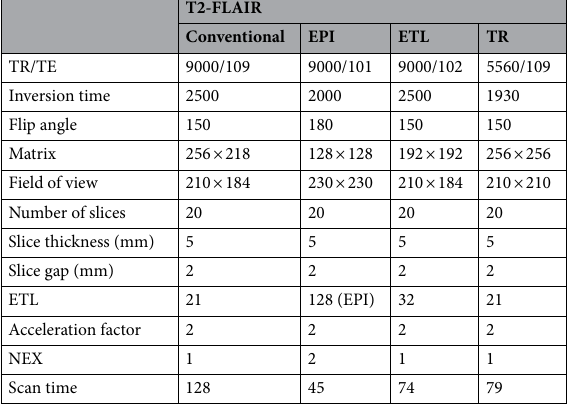
Table 3. T2-FLAIR protocols. EPI echo-planar imaging, ETL echo train length, TR repetition time, TE echo time, NEX number of